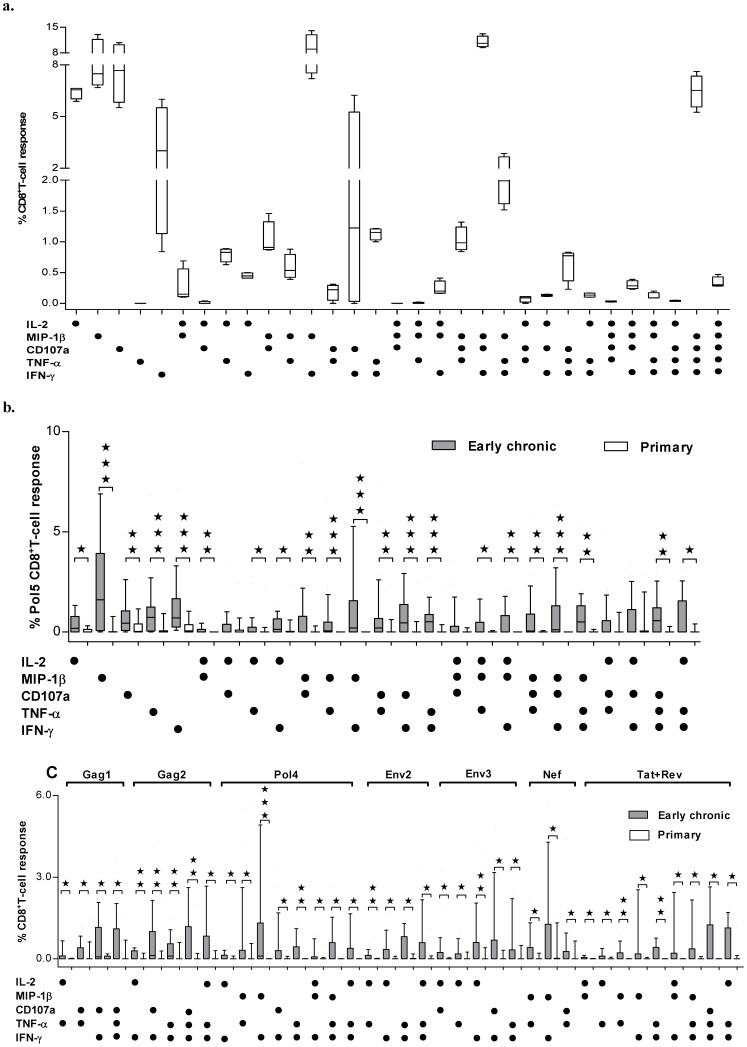
The functional profile of HIV-specific CD8+ T-cell populations during primary and early chronic HIV-1 infections.a. Detailed magnitude of different functional CD8+ T cells after stimulation with PMA and ionomycin. The bar graph provided fine details on the magnitude of 31 different functional subpopulations; the 10th, 25th, 75th, and 90th percentiles and medians were shown. b. Detailed magnitude of different functional CD8+ T cells after stimulation with HIV-Pol5 peptide pool. The bar graph provided fine details on the magnitude of 25 different functional subpopulations (cell subsets with four or five functions were absent in our study); the 10th, 25th, 75th, and 90th percentiles and medians were shown. c. Comparison of the magnitude of different functional HIV-specific CD8+ T cells against a certain peptide pool between primary and early chronic infection groups. For simplicity, only significantly different subpopulations were shown for Gag1, Gag2, Pol4, Env2, Env3, Nef and Tat+Rev responses; no significant differences were identified for those functional combinations not shown. In b and c, asterisks were placed above response pairs that were significantly different: ***p<0.001, **p<0.01 and *p<0.05. Each dot denoted a positive response for the function indicated at the bottom left.